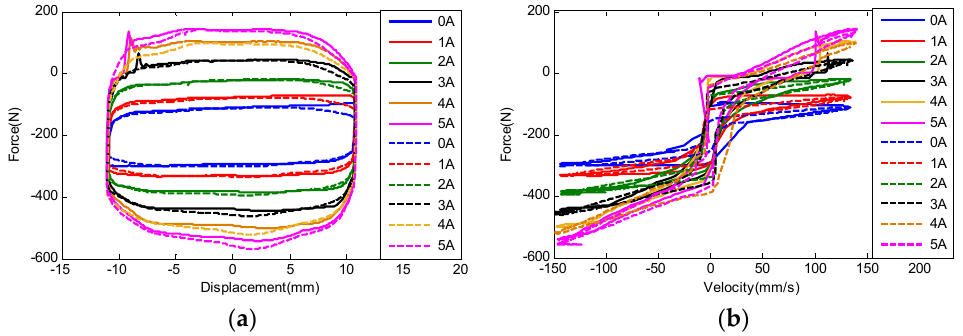
Figure 5. Comparisons of simulation results with experimental results. ( a ) 10 mm–2 Hz displacement–force diagram; ( b ) 10 mm–2 Hz velocity–force characteristic diagram.